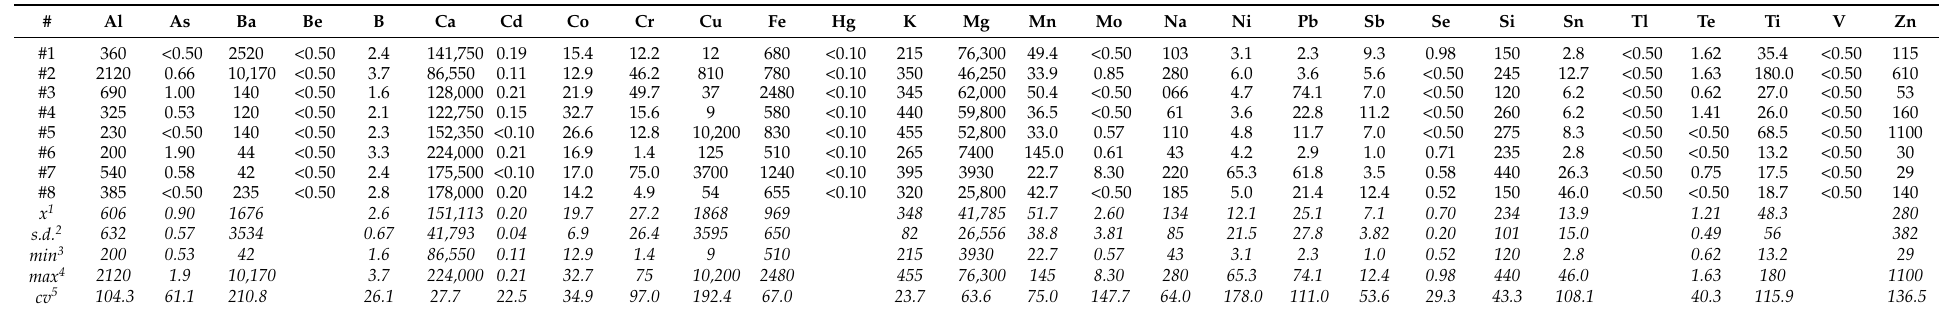
Table 2. Content of heavy metals (mg kg − 1 ) determined by ICP-MS in the different samples investigated. Samples: #1—Pope with red dress; #2—Pope with white dress; #3—gladiator with black crest; #4—gladiator with red crest; #5—gladiator with laurel crown; #6—Santa Klaus; #7—centurion; #8—footballer.